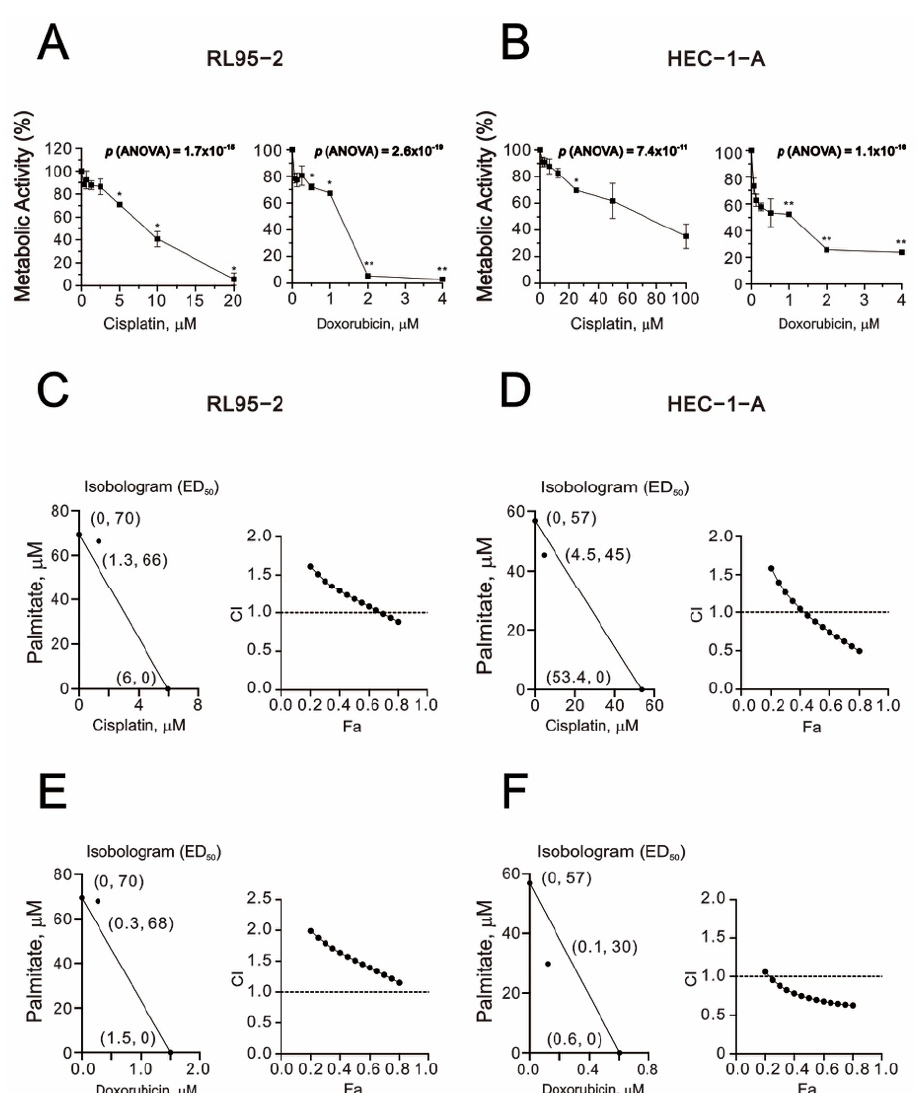
Figure 2. Combination indexes for palmitate with cisplatin or doxorubicin in RL95-2 and